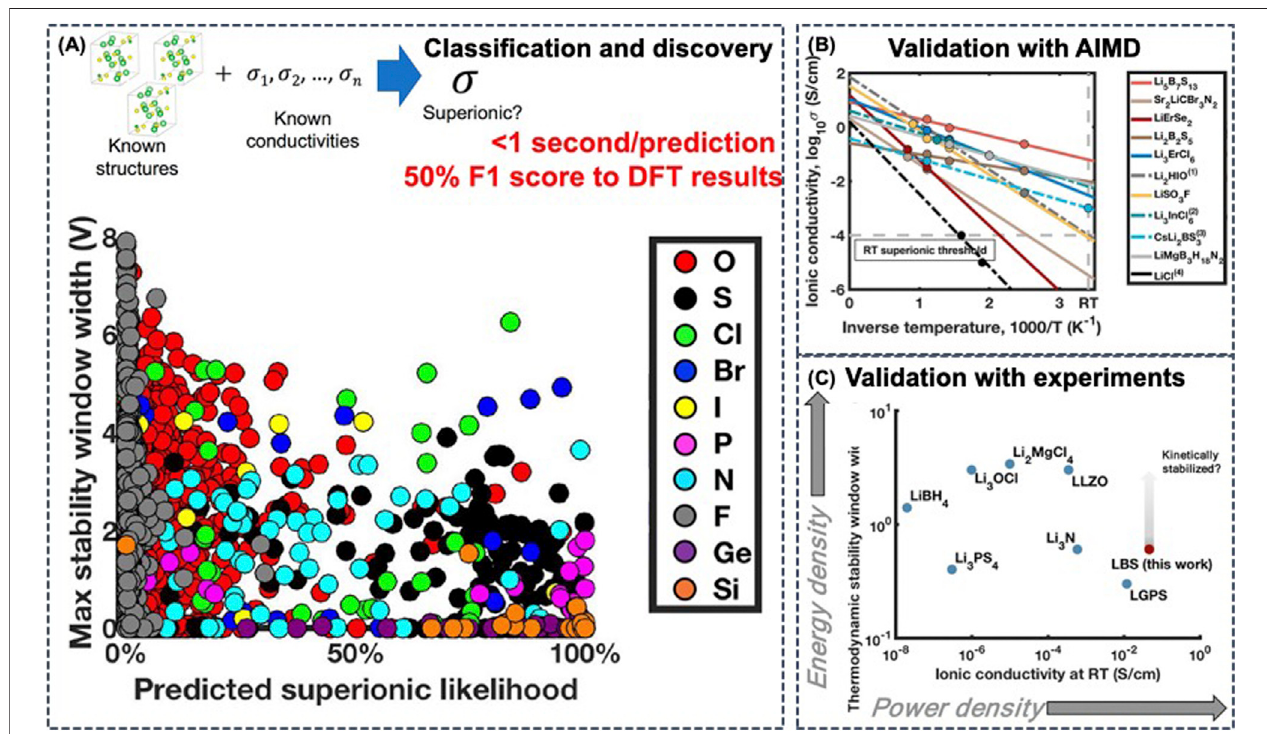
FIGURE 8 | (A) Property spectrum of solid Li-ion conductor candidates by anion family. The predicted metrics of electrochemical stability against predicted likelihood of superionic conduction for stable Li-containing crystalline solid materials from the Materials Project database were plotted. These materials have the general composition Li – (X) – Y, where (X) is any combination of elements and Y is an anion from the following group: F, O, S, Cl, Br, I, N, P, F, Si, or Ge. Reproduced with permission from (Sendek et al., 2019). Copyright 2019 American Chemical Society. Copyright 2020 American Chemical Society (B) Computationally observed ionicconductivity incandidate materials and extrapolationto room temperature (RT).Reproduced with permission from (Sendeket al., 2019).Copyright 2019American Chemical Society (C) The thermodynamic electrochemical stability window widths computed with PBE DFT and the experimentally reported ionic conductivities (on a log – log scale) of several known solid Li-ion conductors, including the predicted values for the best Li – B – S electrolyte compositions. Reproduced with permission from (Sendek et al., 2020b). Copyright 2020 American Chemical Society.